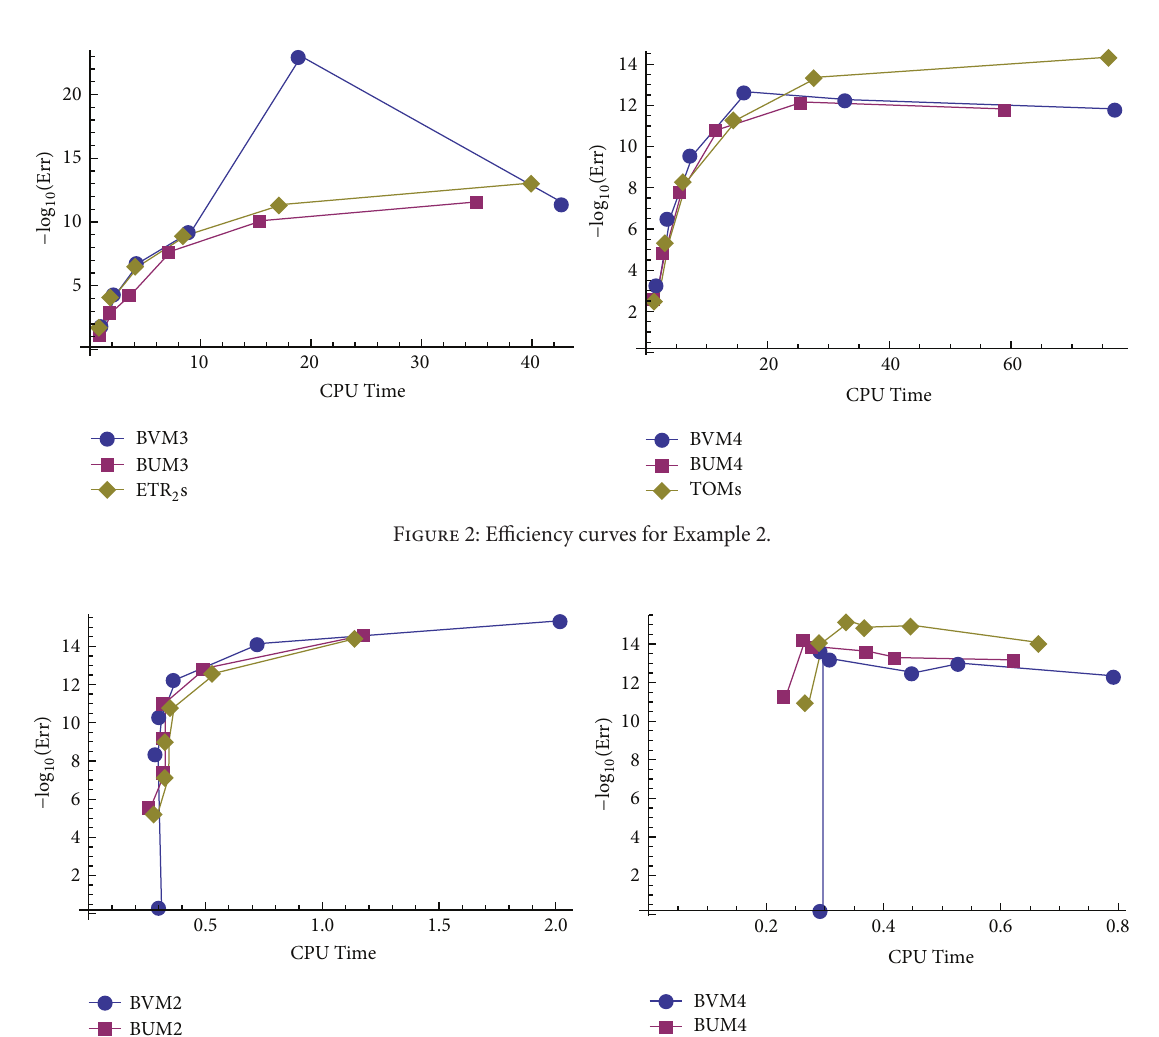
Figure 1: Efficiency curves for Example 1.